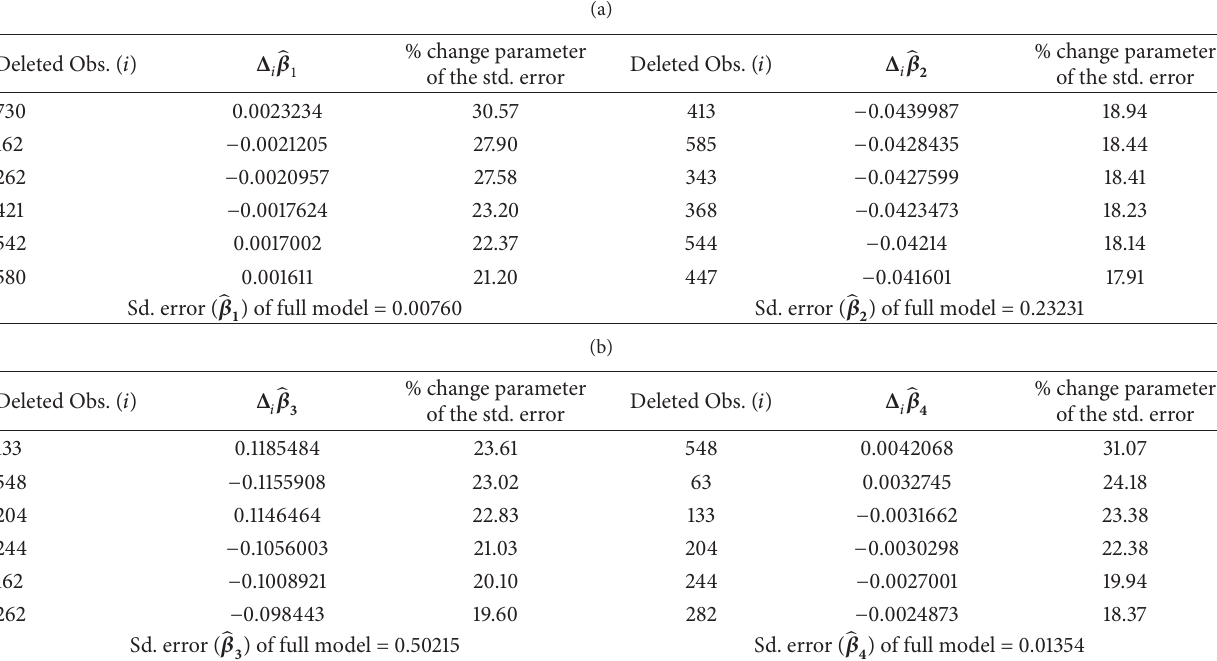
Table 9: The six highest differences in the parameter estimates of the variables included in the model in Table 7 when the data value for each patient is in turn deleted from the model, approximate delta-betas for age (